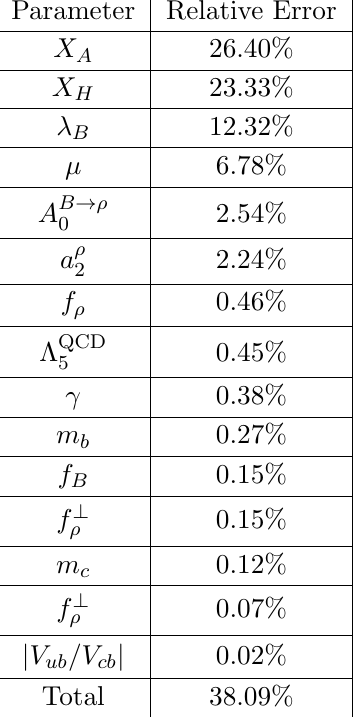
Table 6 . Error budget for the observable R (cid:26)(cid:26) .